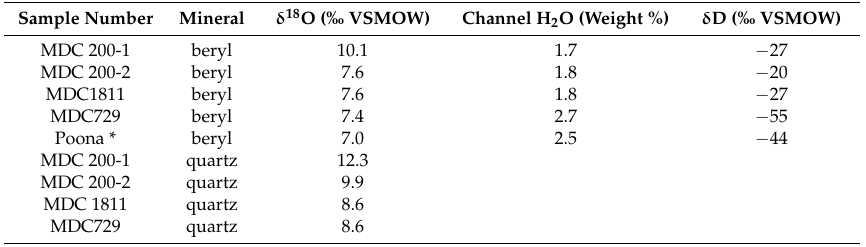
Table 4. Stable isotope data + from Poona quartz and beryl/emerald.